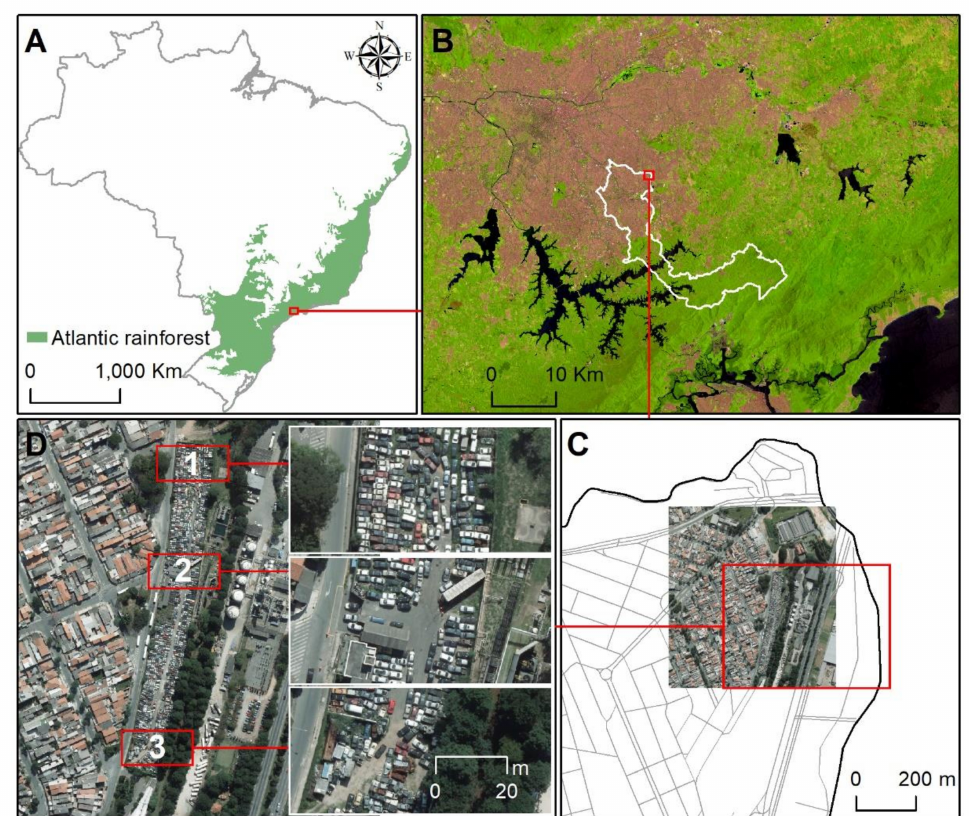
Figure 1. Study area: ( A ) Brazilian Atlantic rainforest; ( B ) municipality of Santo Andr é (white borders) in the metropolitan region of S ã o Paulo, state of S ã o Paulo, southeastern Brazil; ( C ) vehicle impound yard in the Ana Maria Garden district; and ( D ) 1—3 are the sites where we collected mosquitoes. Sources: IBGE (biomes), USGS (Landsat 8OLI), SEMASA (aerophotogrammetric image), and ArcGIS v.